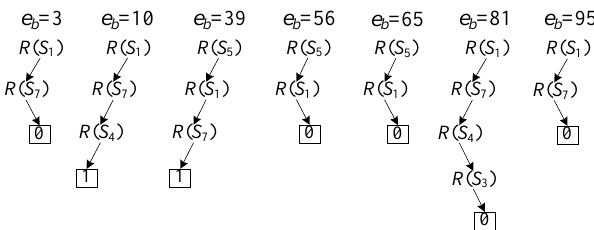
Figure 5. The procedure of computing evaluation